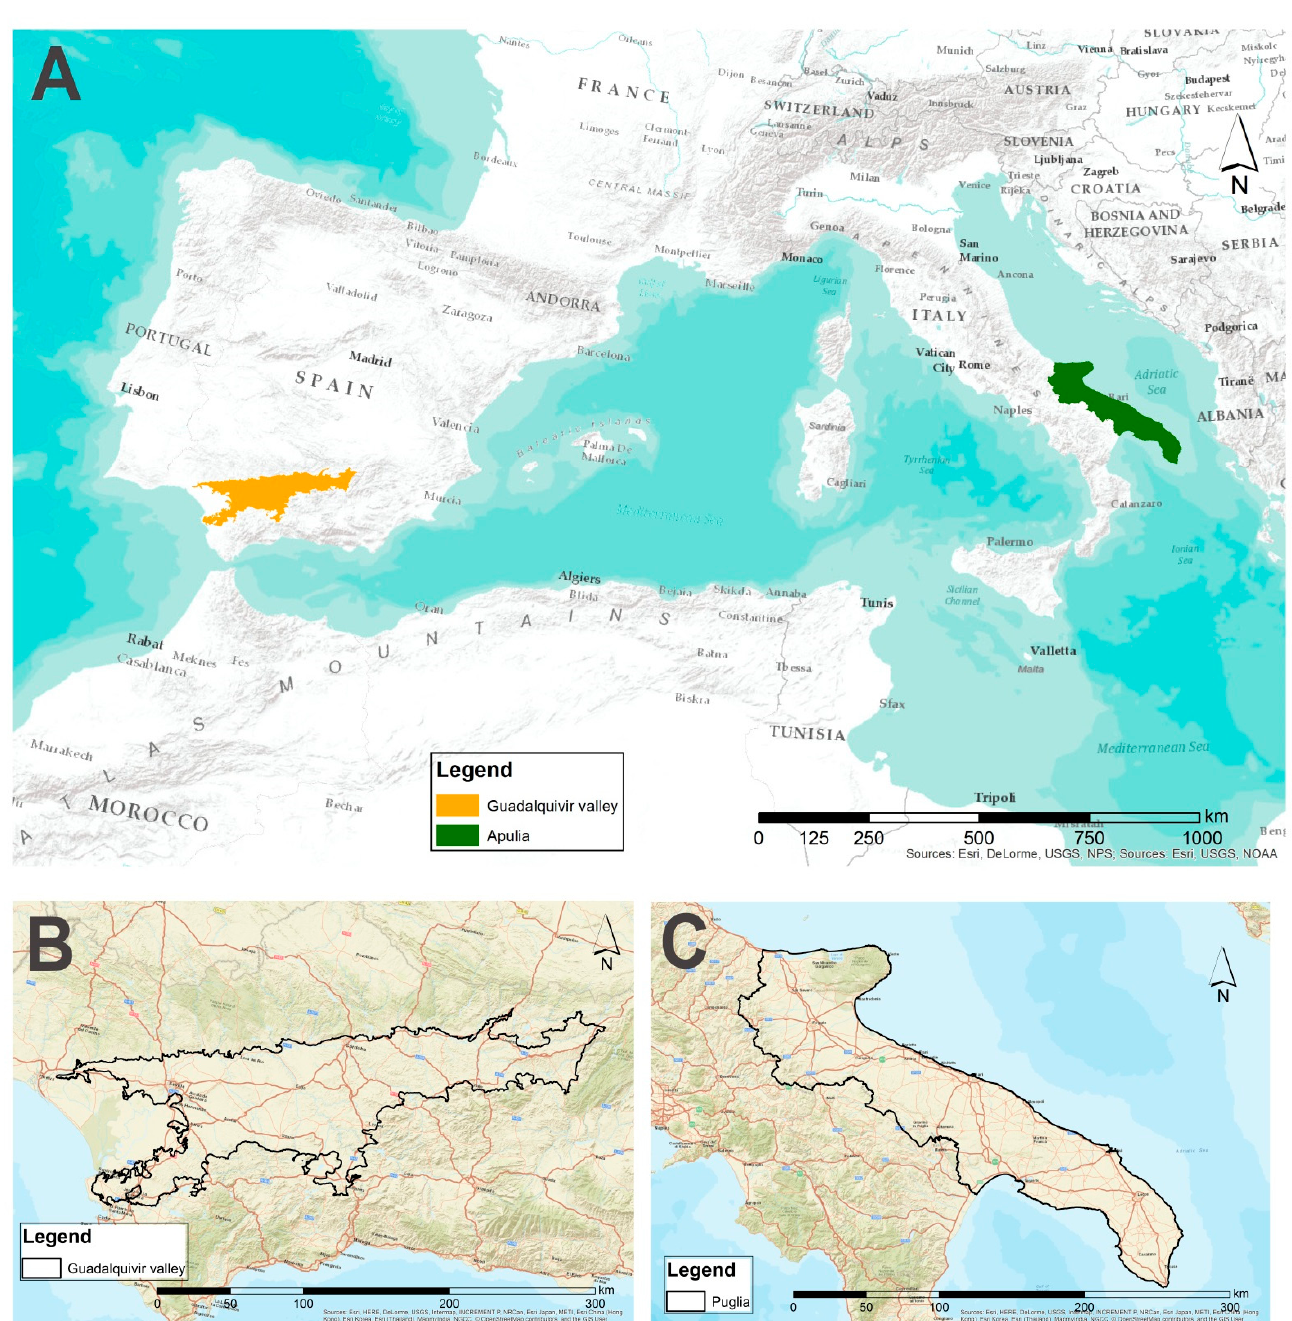
Figure 2. Location of the study area. ( A ): In orange, the Guadalquivir valley in Spain, in green, the Apulia region in Italy. ( B ): Detail of the Guadalquivir valley and features of the terrain including Intact Forest Landscape (IFL, ESRI © ) in the light green color. ( C ): Apulia region using the same reference cartography. The absence of nature/native forest in the selected regions is remarkable.